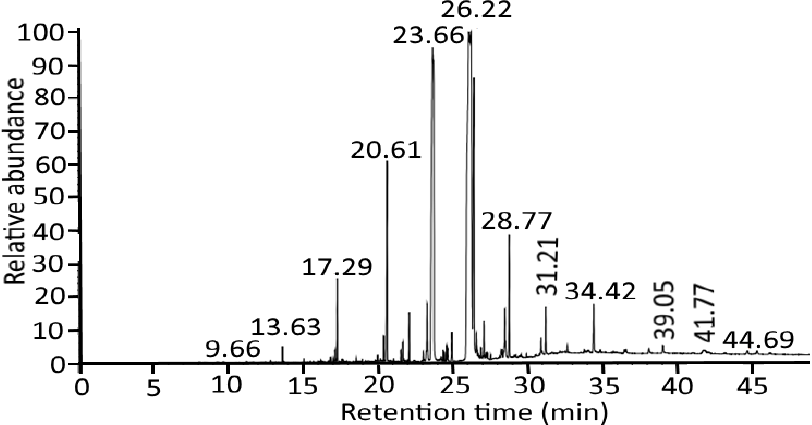
Figure 1. GC–MS chromatogram of Azadirachta indica oil showing major bioactive compounds with prominent peaks at different retention times. Table 1. Potential bioactive components of Azadirachta indica oil revealed by GC–MS analysis. Compound